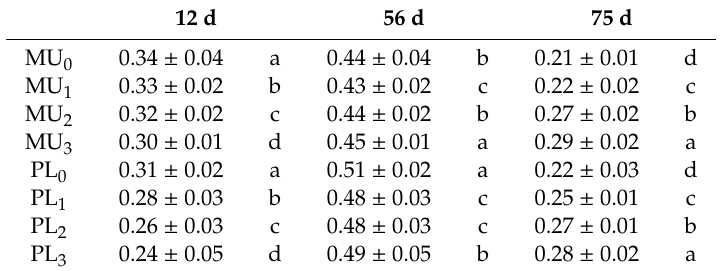
Figure 4. Comparison of total length and weight of rice root under di ff erent straw returning treatments. A and B are the total root length of mulching and plowing treatment respectively; C and D are the fresh weight of rice root for mulching and plowing treatment respectively. Table 2. Comparison of root shoot ratio under di ff erent straw incorporation treatments.